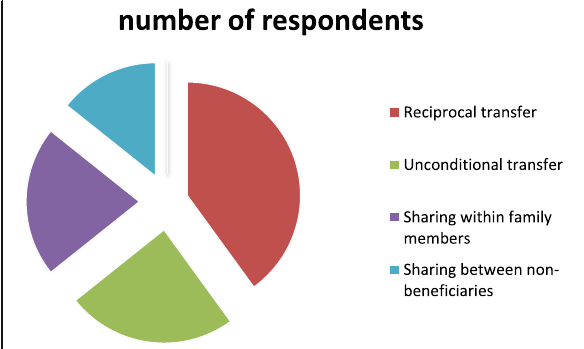
Fig. 1 Data on the proportion of the different type of horizontal sharing (field survey